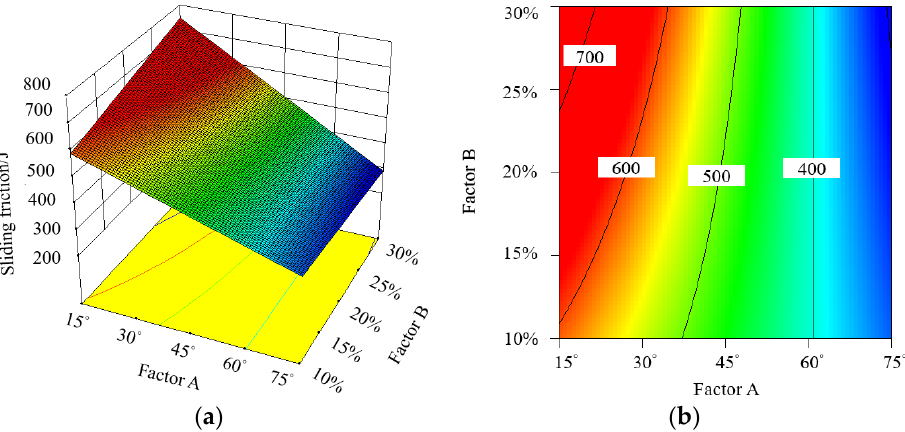
Figure 10. Response surface diagram and contour map of factor A and B on interaction of sliding friction work. ( a ) Response surface diagram; ( b ) contour map. The four contour lines mapped on the bottom of Figure 10a correspond to the four types of sliding friction work in Figure